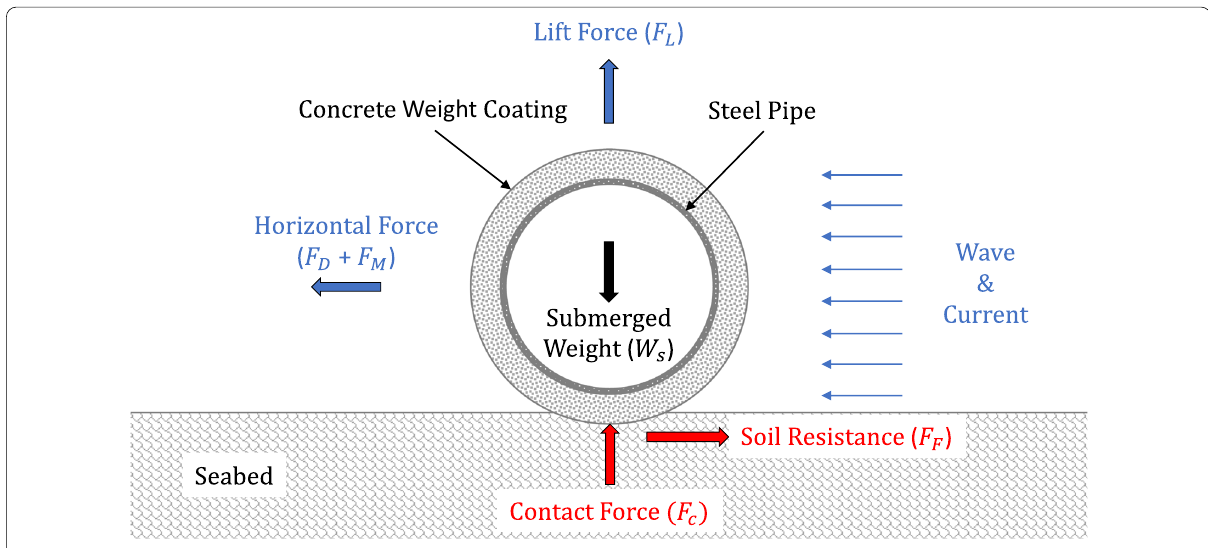
Fig. 1 Forces affecting subsea